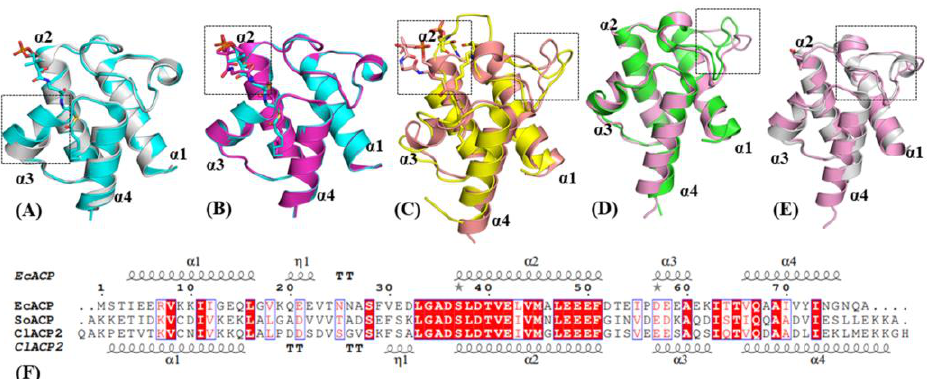
Figure 1. Comparisons of the structures and sequences of ACPs. ( A ) Structure overlay of EcACP by apo form (PDB entry 1T8K, colored gray) and C7-acylation form (PDB entry 2FAD, colored cyan). ( B ) Structure overlay of EcACP by C7-acylation form and C10-acylation form (PDB entry 2FAE, colored purple). ( C ) Structure overlay of SoACP by C10-acylation form (PDB entry 2FVF colored salmon) and C18:0-acylation form (PDB entry 2FVA, colored yellow). ( D ) Overlay of SoACP (PDB entry 2FVE, colored green) and ClACP2 (colored pink). ( E ) Overlay of EcACP by apo form and ClACP2. ( F ) Sequence comparison of EcACP, SoACP, and ClACP2. The red boxes show the 100% conserved residues; residues having similar properties are shown in blue boxes.